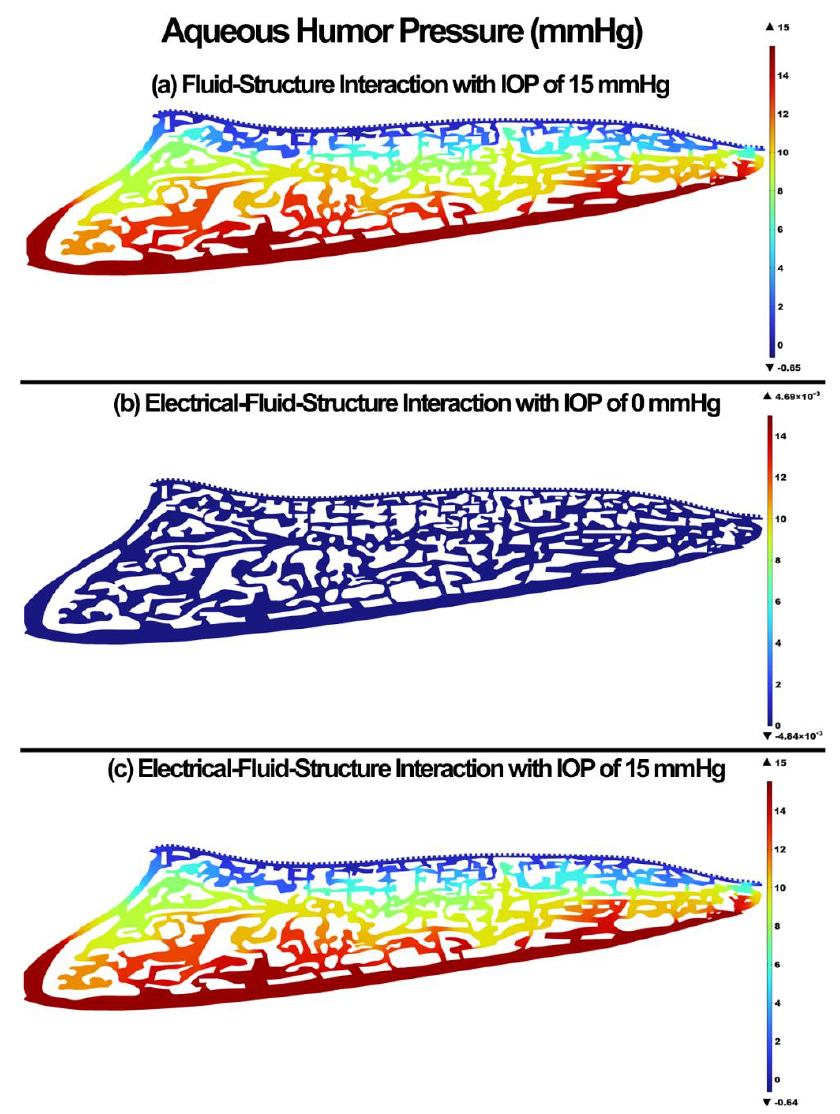
Figure 2. The aqueous humor pressure across the outflow pathway. ( a ) FSI model with IOP of 15 mmHg, ( b ) EFSI with IOP of 0 mmHg, and ( c ) EFSI with IOP of 15 mmHg.